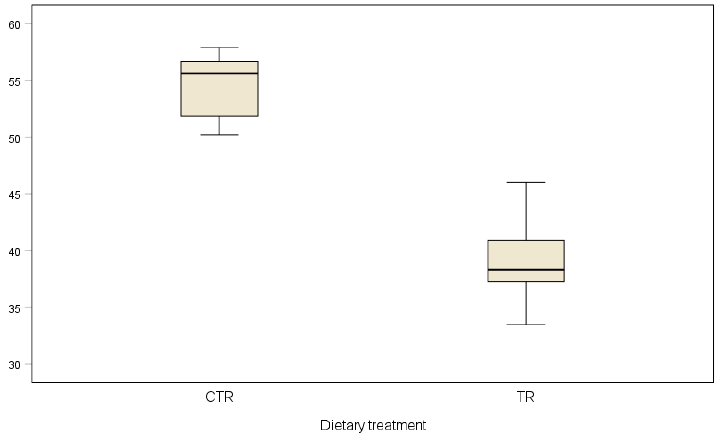
Figure 2. Spider plot of Longissimus lumborum muscle cholesterol content of Charolais beef cattle fed control diet (CON) and diet supplemented with omega-3 lipid supplement (TR). control diet (CON) and diet supplemented with omega-3 lipid supplement (TR).